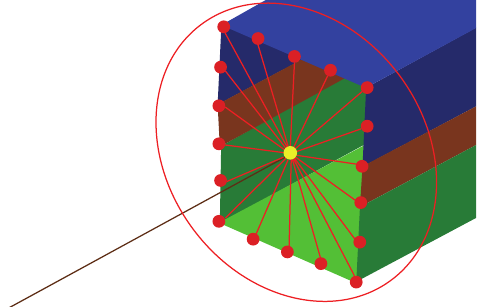
Figure 3: The interface element (circled in red) between equivalent 1D beam model and detailed 3D joint model. The central node is in yellow (dependent node on the beam side) while the peripheral nodes are in red (independent nodes on the joint side).